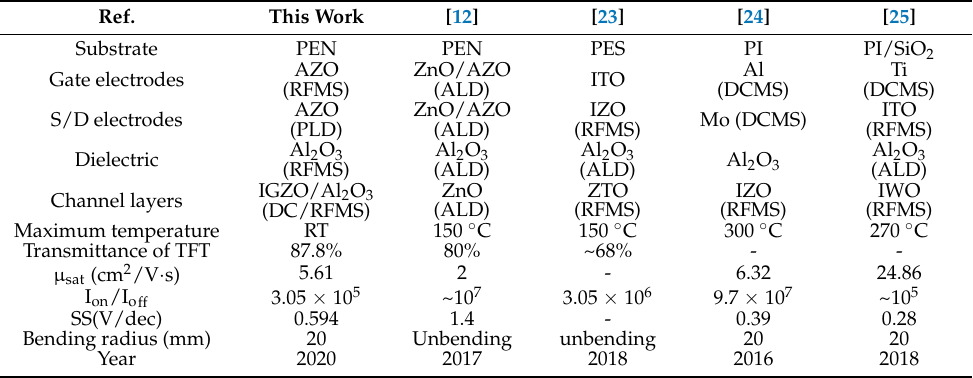
Table 2. Summary of transparent oxide TFTs prepared on flexible substrates from the literature, including the device presented in this